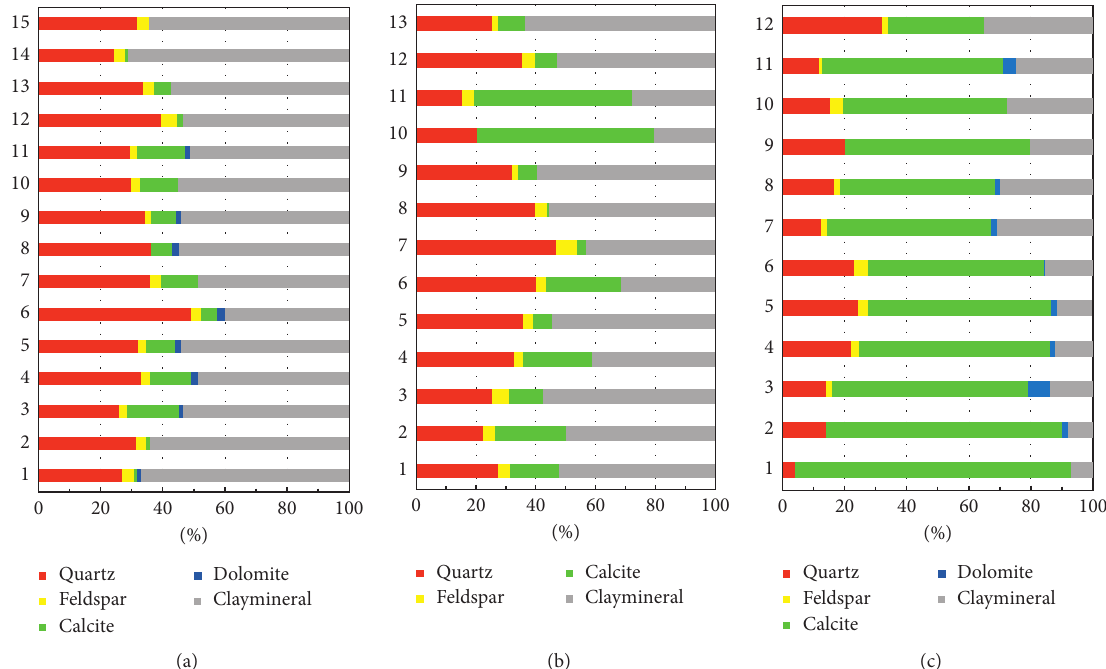
Figure 4: XRD analysis of the distribution of different mineral compositions of fine-grained rocks in the Da’anzhai Member in the Sichuan Basin. (a) Characteristics of the mineral composition in the northern Sichuan Basin, 15 samples. (b) Characteristics of the mineral composition in the eastern Sichuan Basin, 13 samples. (c) Characteristics of the mineral composition in central Sichuan Basin, 12